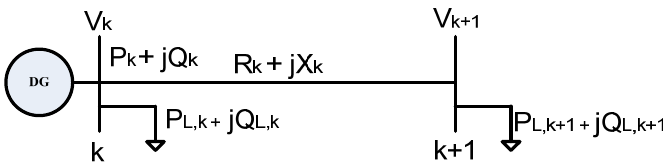
Figure 1. Two-bus distribution system for load flow analysis.